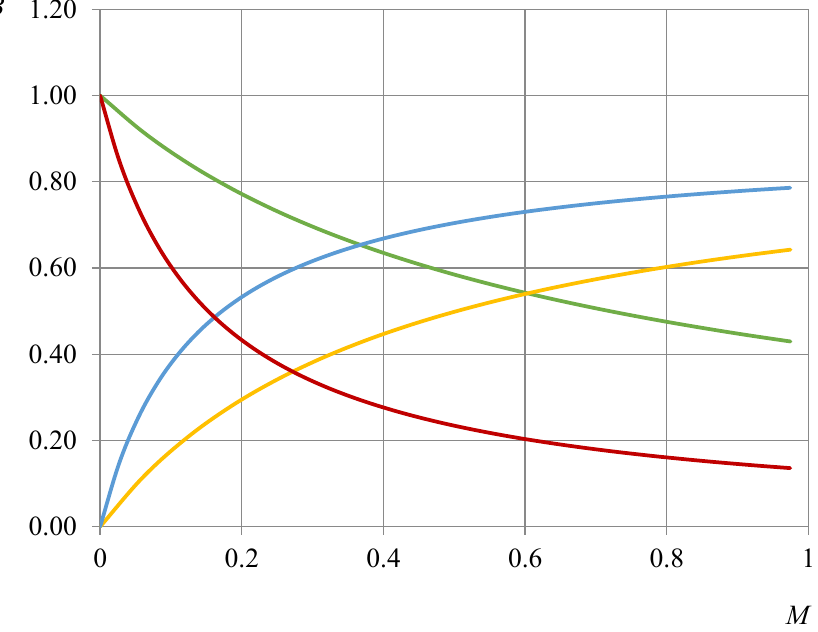
Figure 2. The correlation of CC performance criteria and the dimensionless mass of the injected gelling agent (green line—injectivity drop S for linear inflow, red line—injectivity drop S for radial inflow, yellow line—CC coefficient B for linear inflow, blue line—CC coefficient B for radial